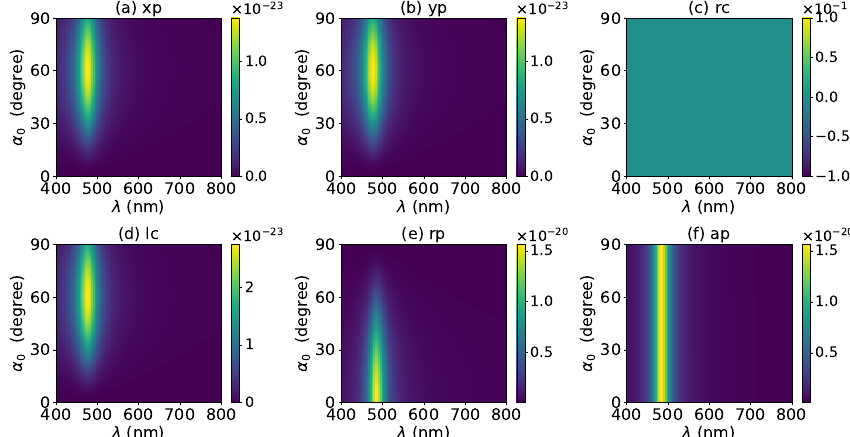
Figure 25. The axial optical torque T z of a first-order Bessel beam centered on a graphene-coated gold nanosphere. The layer number is N = 0, which means the particle is a gold nanosphere without graphene coating. Panels ( a – f ) correspond to linear, circular, radial, and azimuthal polarizations, respectively.